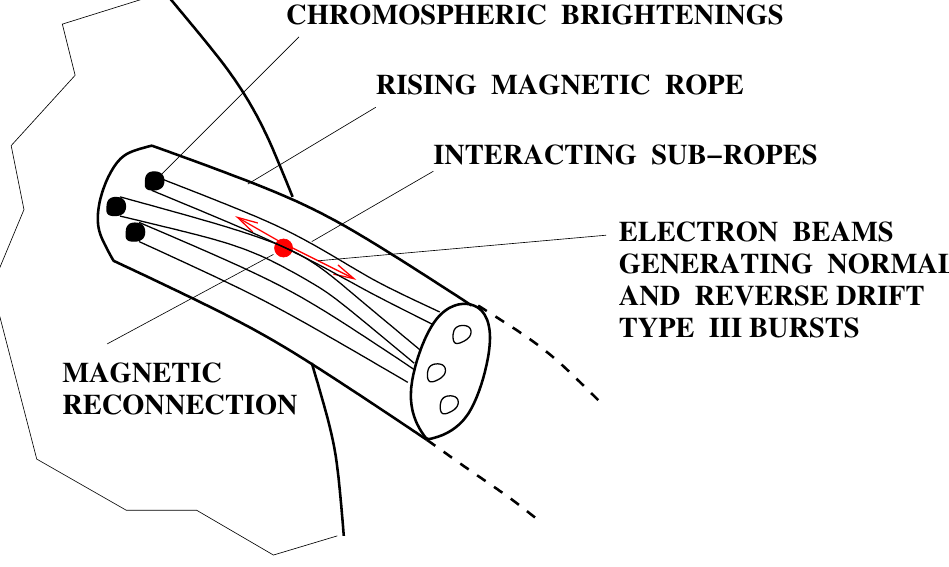
Figure 9. A sketch of the analyzed processes